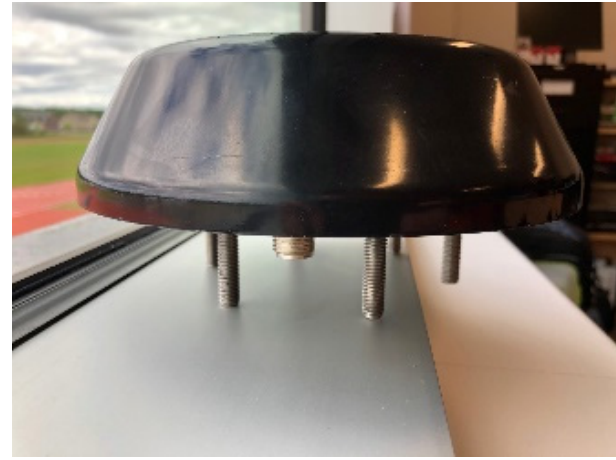
Figure 17. Specific UHF railway antenna.